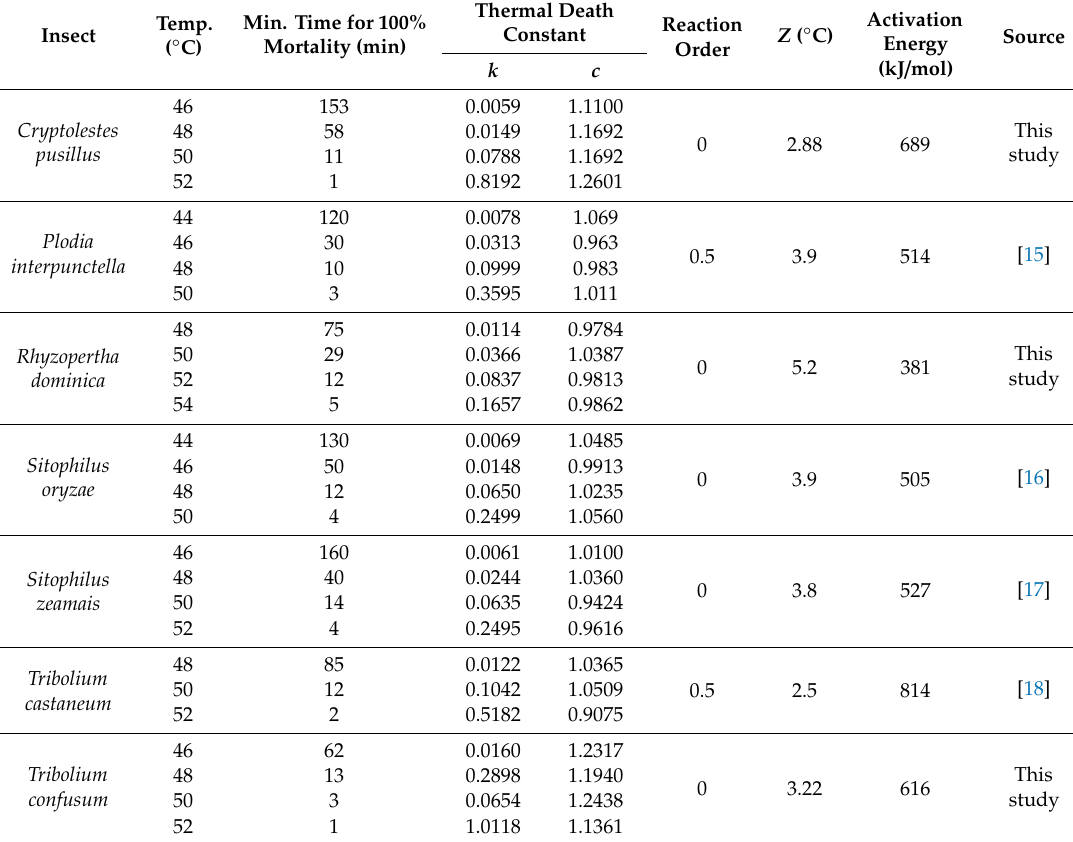
Table 4. Comparison of lethal times and kinetic parameters for thermal treatment between adult lesser grain borer and other storage